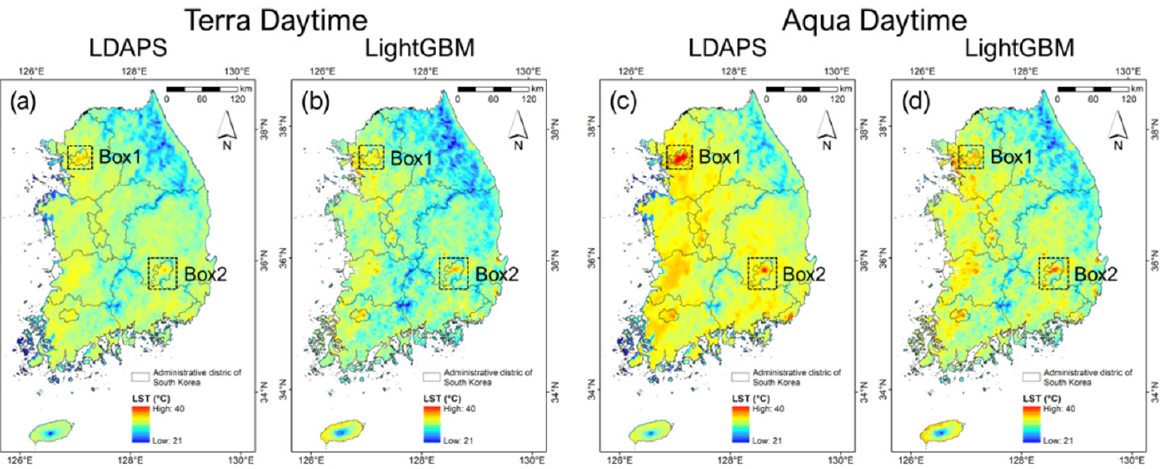
Figure 7. Spatial distribution of the average all-sky 1 km LSTs for Terra and Aqua daytime produced by ( a , c ) LDAPS and ( b , d ) LightGBM in June–August from 2013 to 2020. The enlarged LST distri- butions of ( e , g , i , k ) LDAPS and LightGBM ( f , h , j , l ) are shown for two subset areas (i.e., boxes 1 and 2), which are representative metropolitan areas in South Korea that often suffer from summer heatwaves.